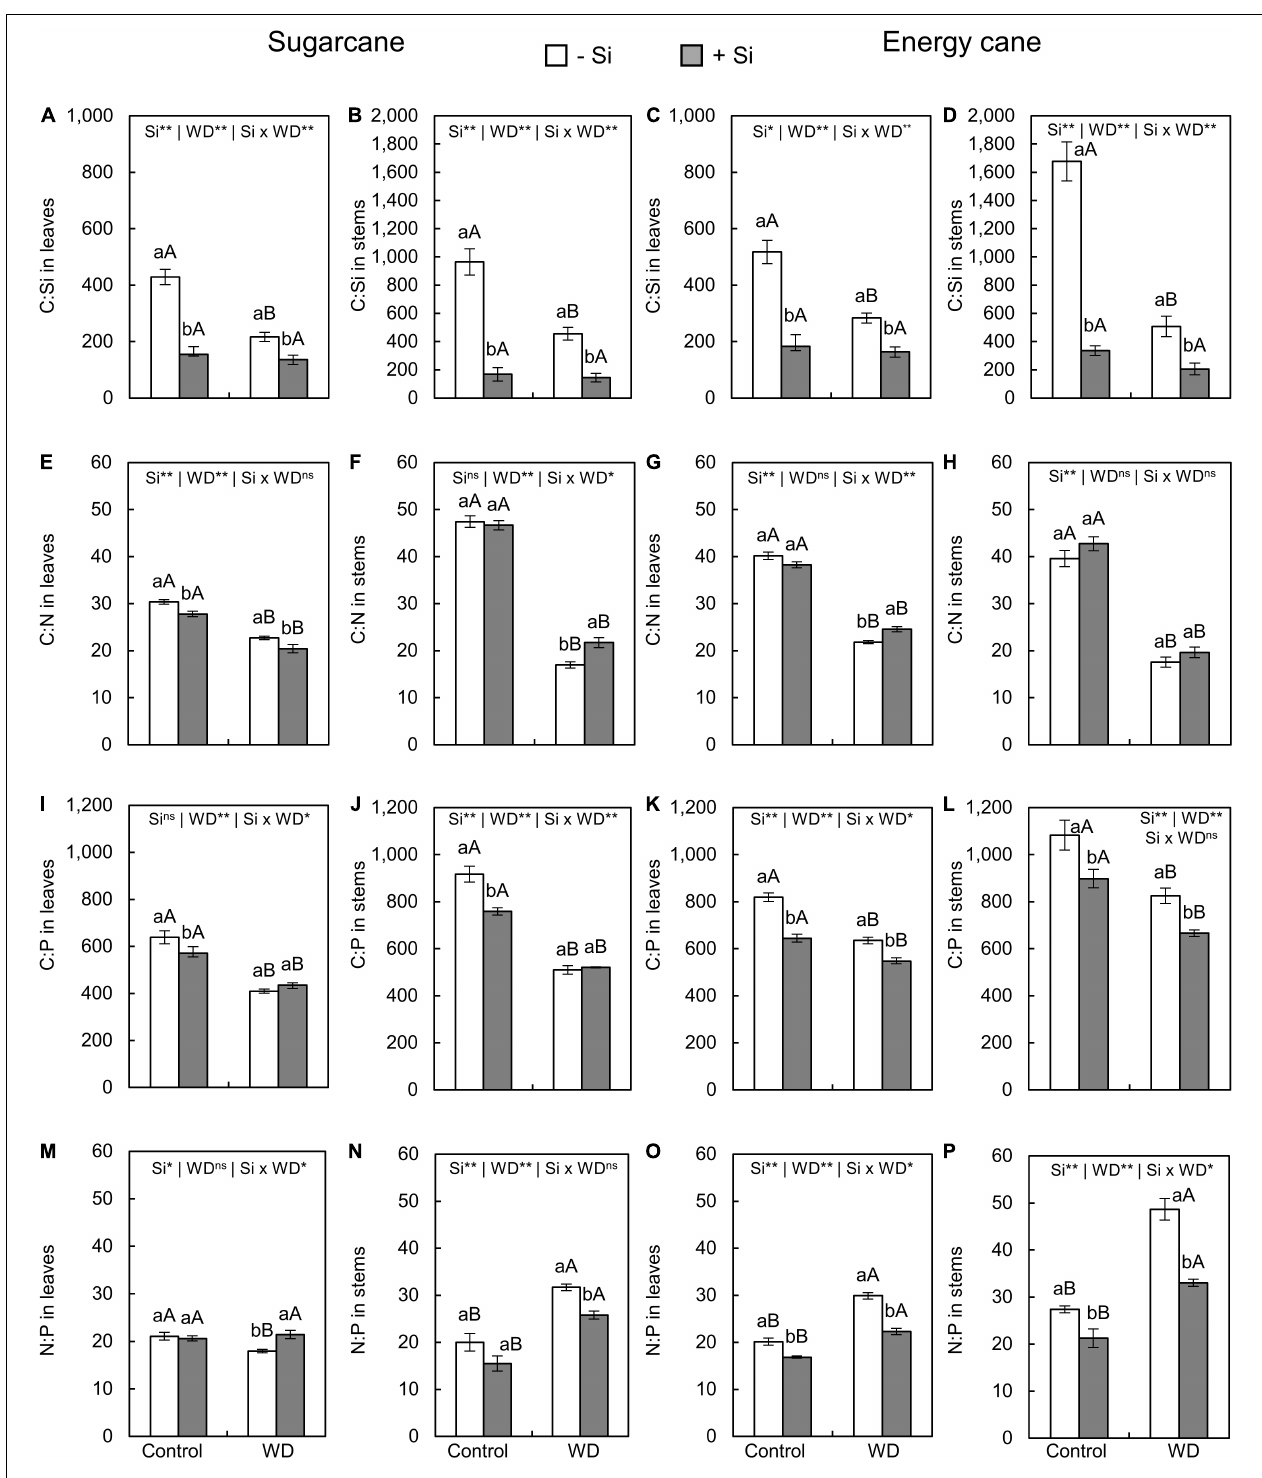
FIGURE 6 | C:Si, C:N, C:P, N:P ratios in the leaves and stems of sugarcane (A,B,E,F,I,J,M,N) and energy cane (C,D,G,H,K,L,O,P) in -Si and + Si under adequate water regime (control) and in WD for a period of 7 to 160 days after transplantation. ** and * significant with 1 and 5% probability, respectively, and ns, not significant by the F -test. Lowercase letters indicate differences in relation to Si and capital letters in relation to water deficit. n = 5. Si × WD: interaction.